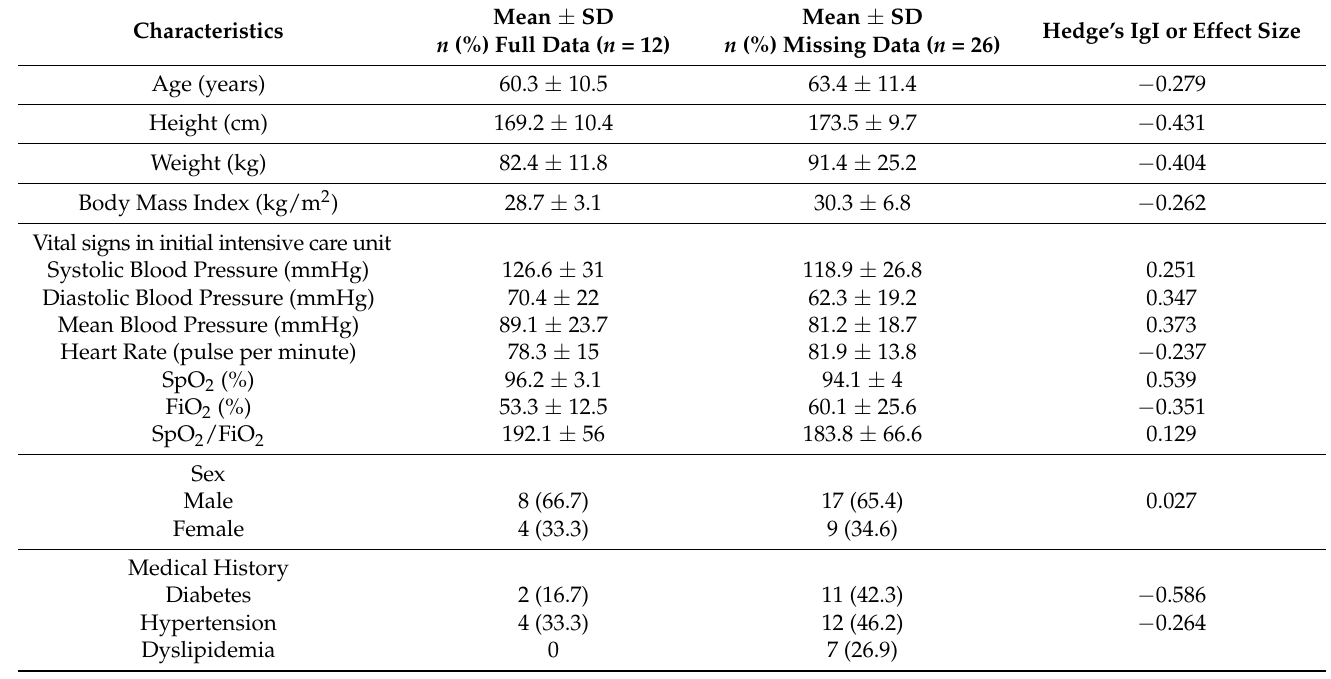
Table A1. Baseline characteristics of patients with data in all nine time points of measurement and those without data in all nine time points of